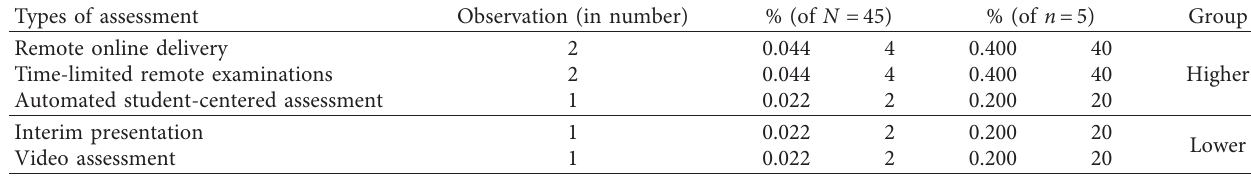
Table 13: Percentage of each type of assessment in online learning and their groups based on 50th quartile.